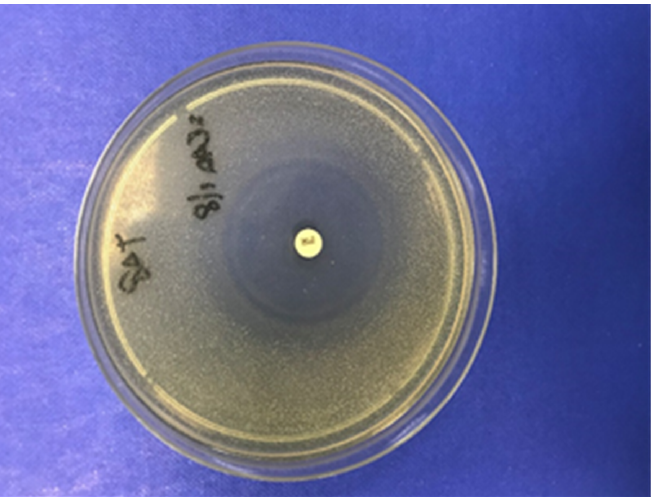
Figure 1. Positive control used for the detection of residual antibiotic activity (RAC). The disk contains 30 µg of tetracycline (TCL).